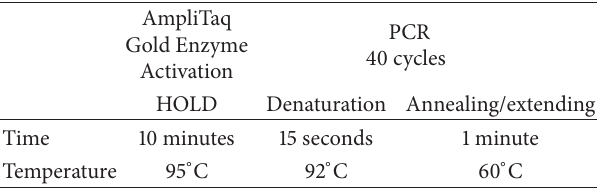
Table 3: Demographic and clinical characteristics